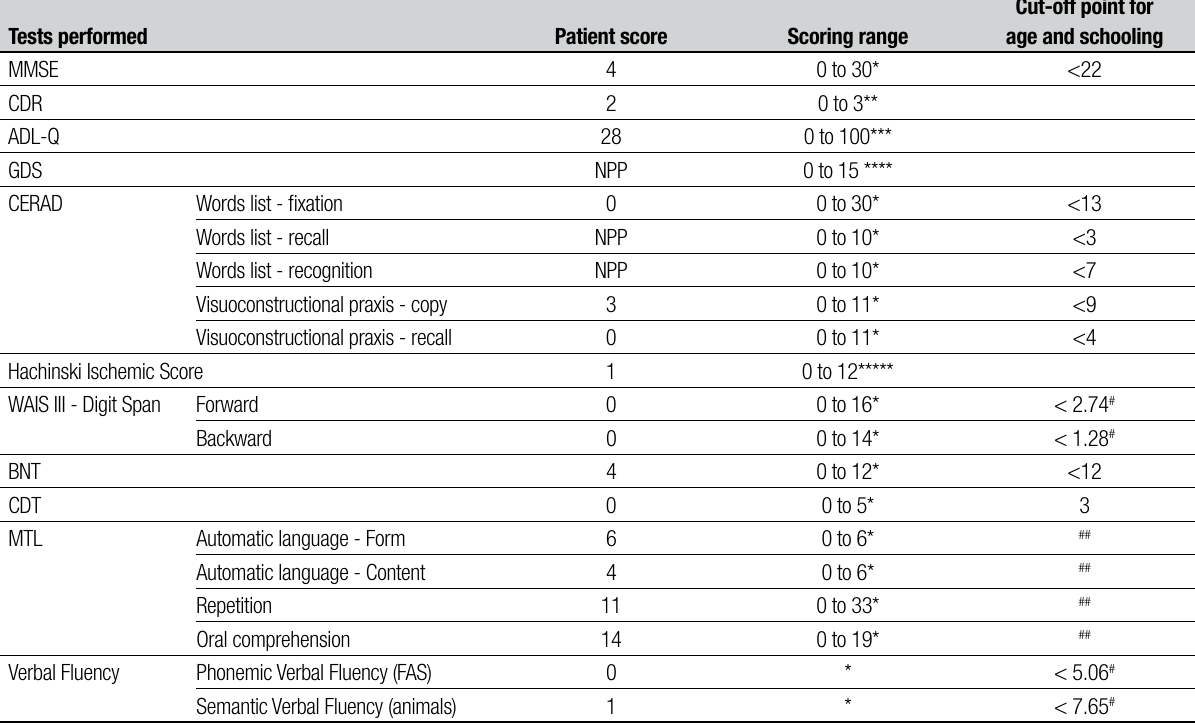
Table 1. Scores from cognitive assessment.